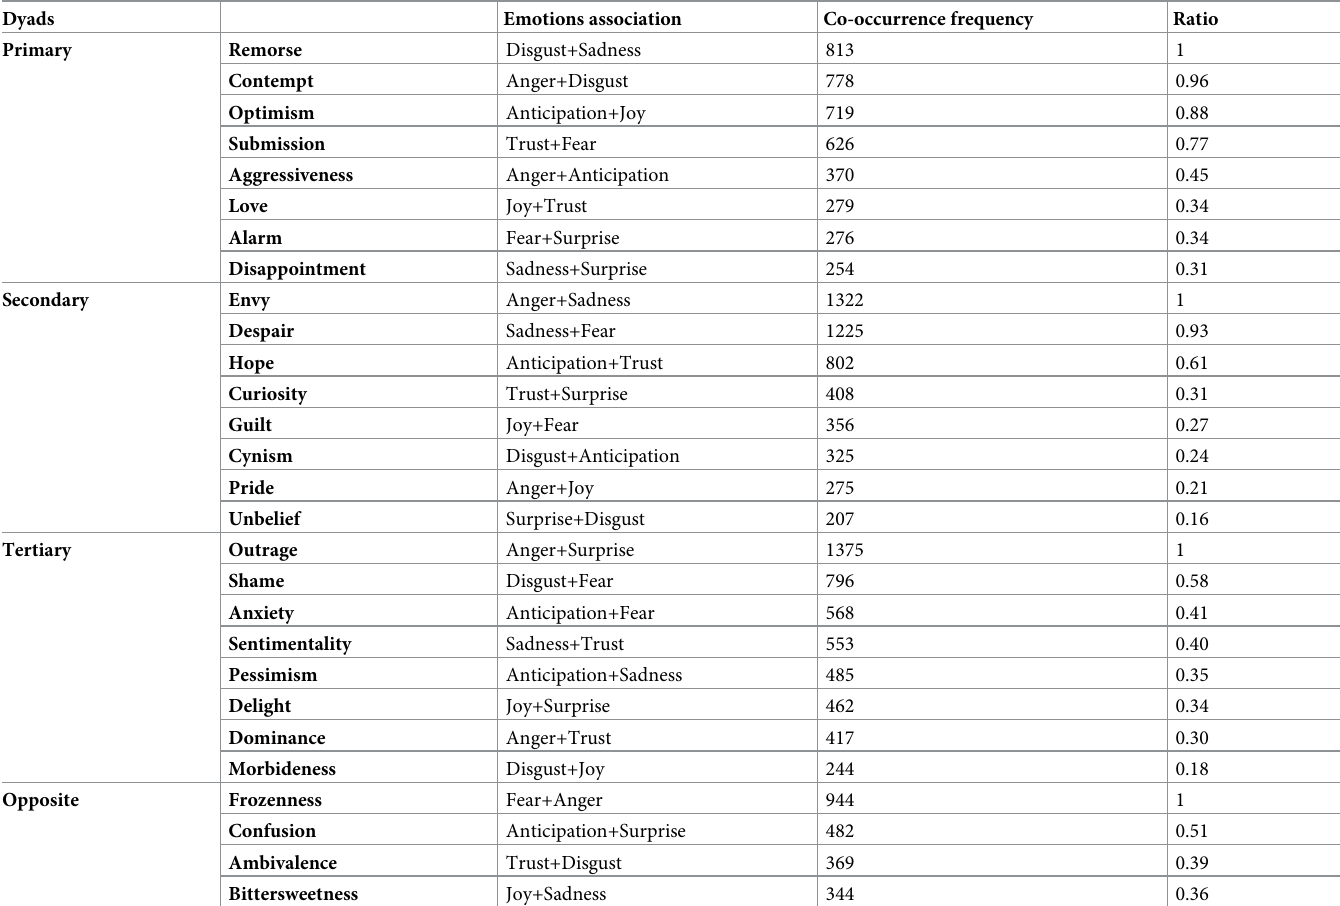
Table 5. The co-occurrence of